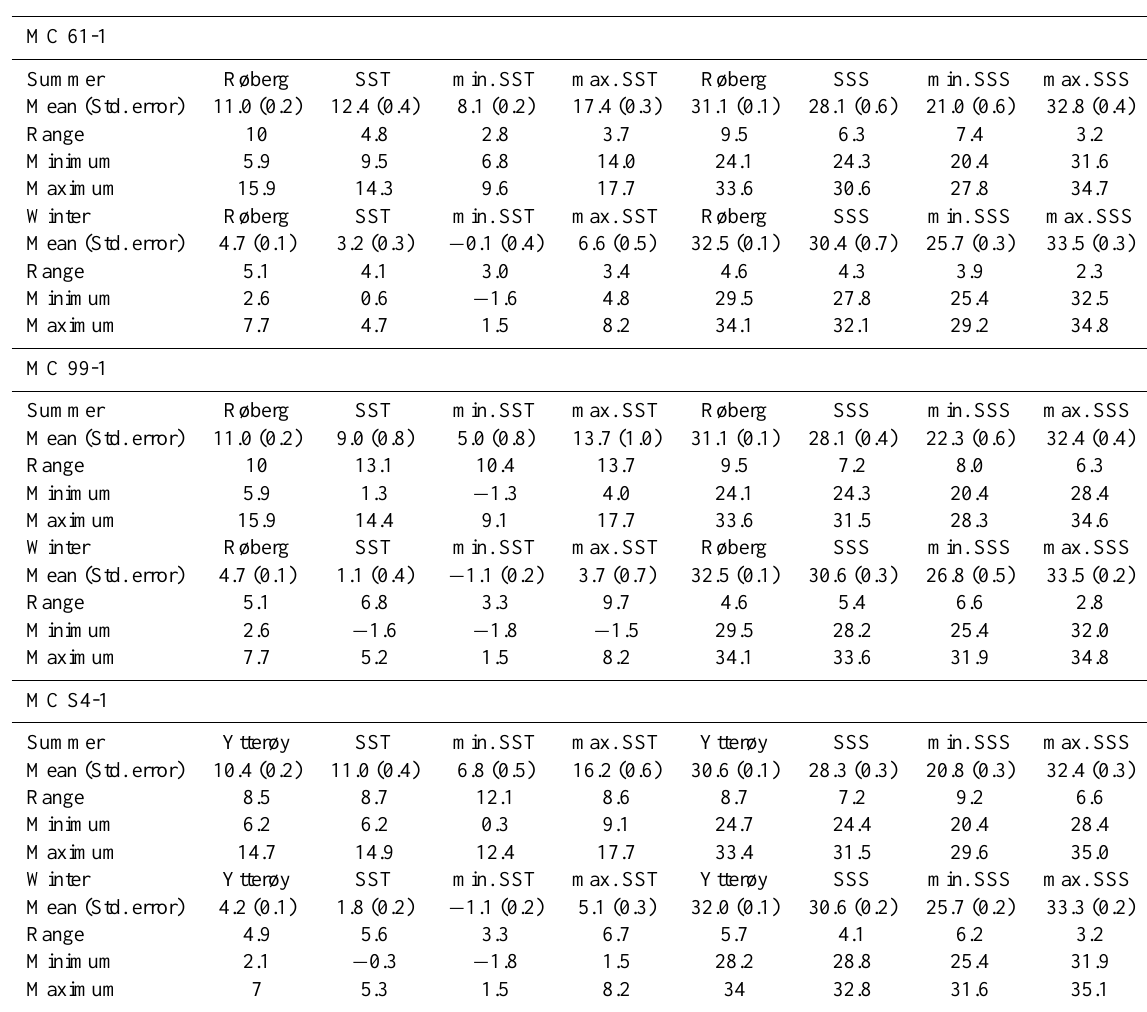
Table 3. Descriptive statistics (mean, range, minimum and maximum values) of hydrographic characteristics measured at each mooring station at 10m water depths and of MAT reconstructions of winter and summer SSTs and SSSs (confidence level 95%); instrumentally measured SSTs and SSSs are denoted by the name of the mooring stations, Røberg and Ytterøy; estimated SSTs and SSSs including min. and max. values are marked by the core names MC 61-1, MC 99-1 and MC S4-1. Standard errors (Std.e.) for the mean values are given in